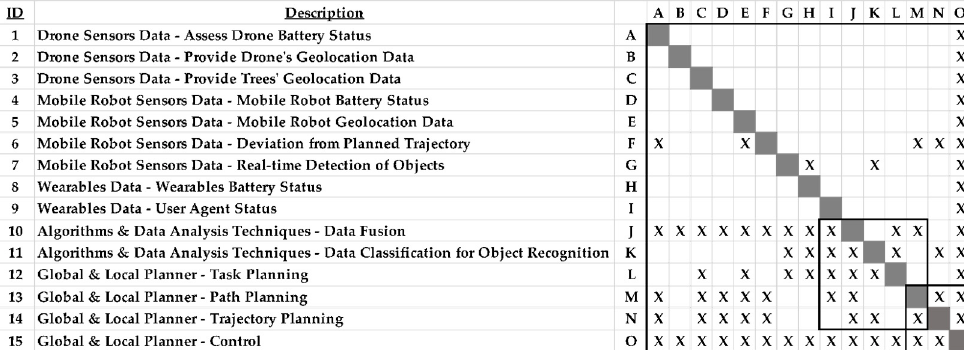
Figure 5. Decomposition of the information sub ‐ system.